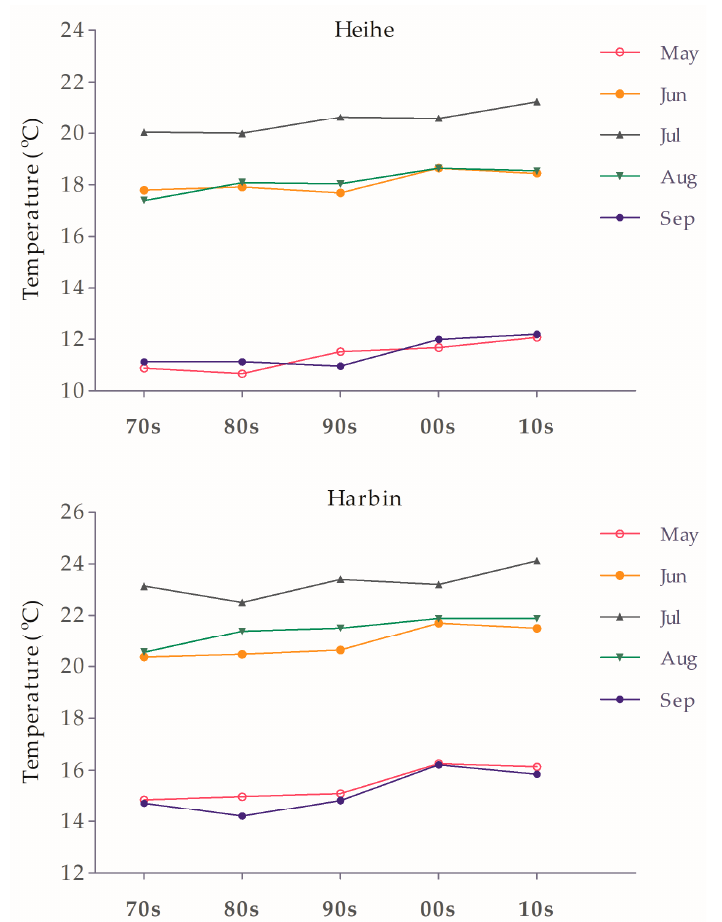
Figure A2. Mean of 10-year monthly temperatures during 1970–2019 in Heihe and